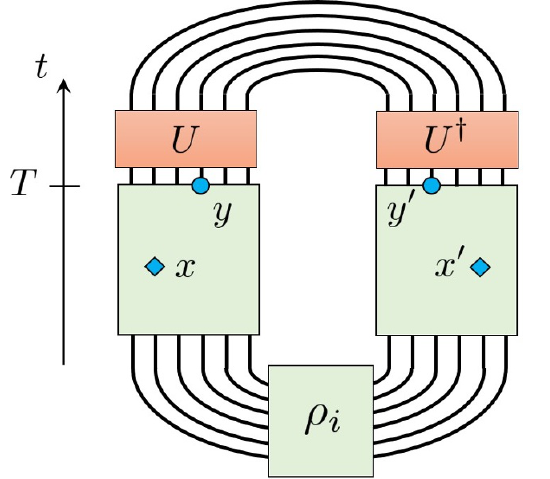
Figure 8 . A spacetime state, such that operators are not inserted later than a time T . Then the unitary evolution U after time T cancels out with the corresponding unitary evolution U y